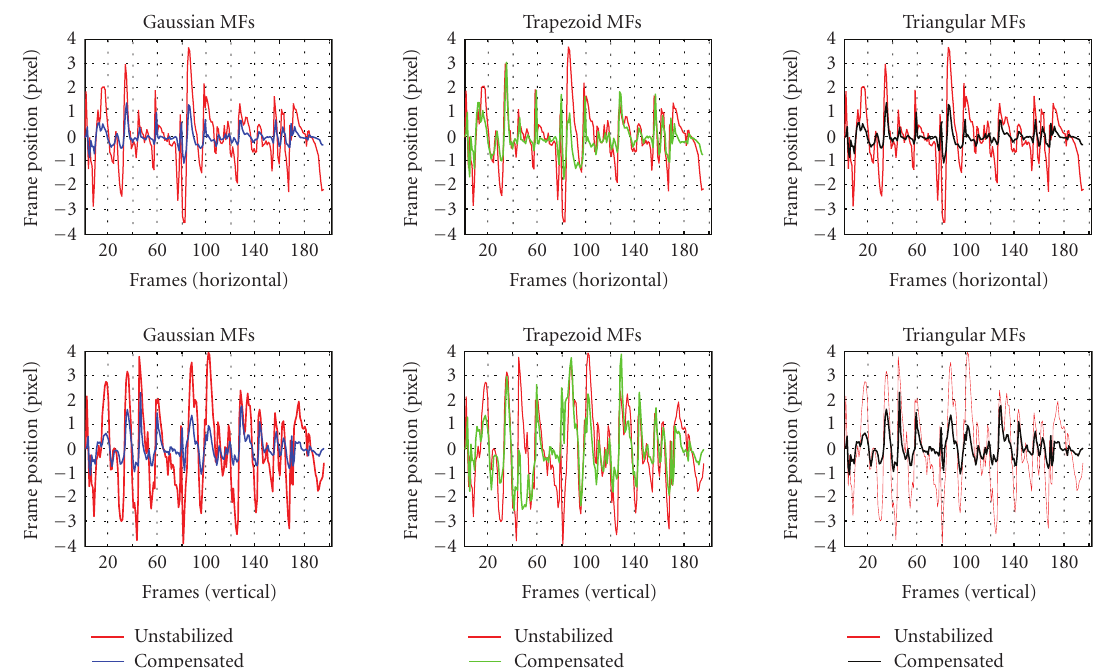
Figure 8: The red line presents each frame position before stabilization the blue, the green, and the black line the stabilized one for Gaussian, trapezoid, and triangular MFs,